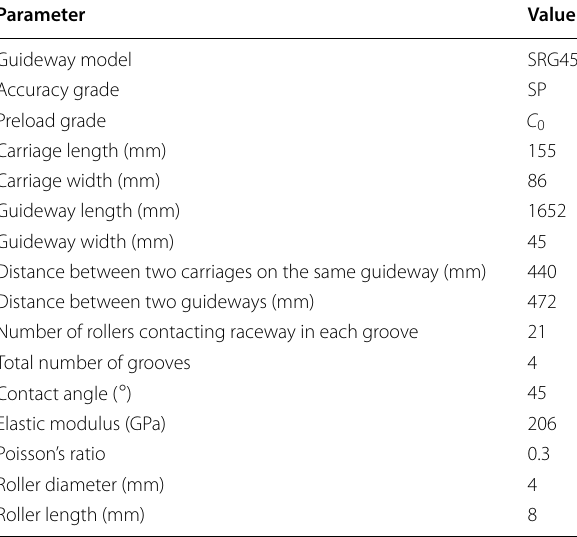
Table 1 Attribute parameters of rolling